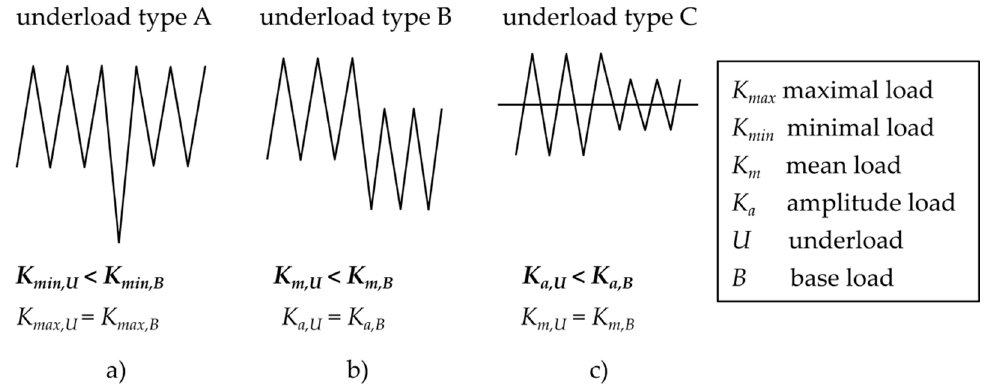
Figure 3. The three types of underloads considered in literature: ( a ) a single underload with the shift of K min , ( b ) underloads with reduced mean load, and ( c ) underloads with reduced load am-